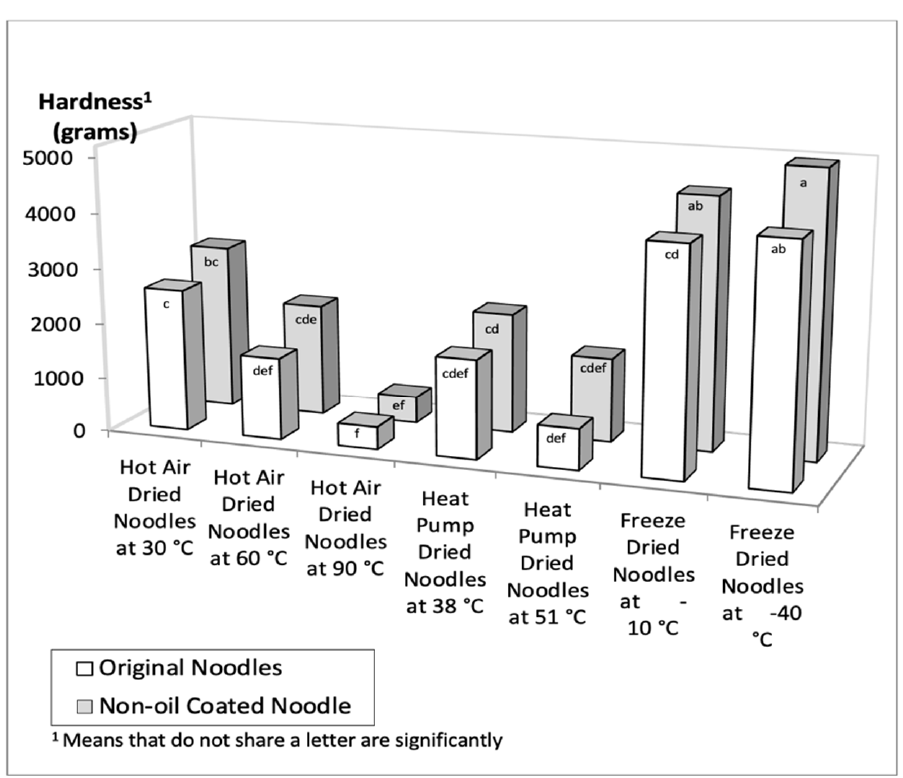
Figure 1. Hardness test of rice noodle at hot air drying (HAD), heat pump drying (HPD) and freeze drying (FD). Means of hardness test that do not share a letter in the figure are significantly different.